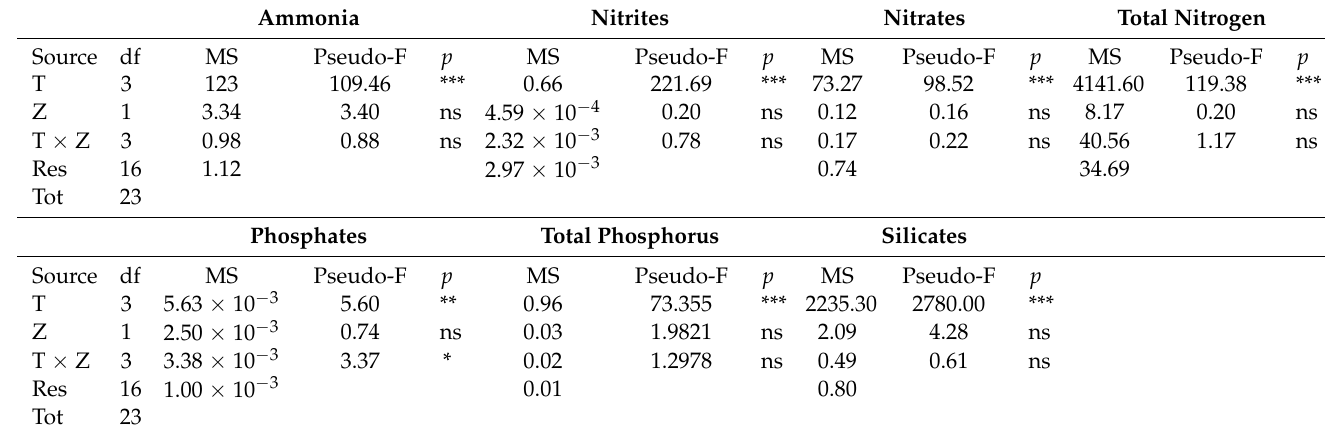
Table 2. Results of the permutational analyses (PERMANOVA) on ammonia, nitrates, nitrites, total nitrogen, phosphates, total phosphorus, and silicates in the water columns of W and E zones (Z) among sampling times (T). Abbreviations: Res—residual; Tot—total; df—degrees of freedom; MS— mean squares; Pseudo-F—F critic; P—permutational level of probability. * p < 0.05; ** p < 0.01; *** p < 0.001; ns—not